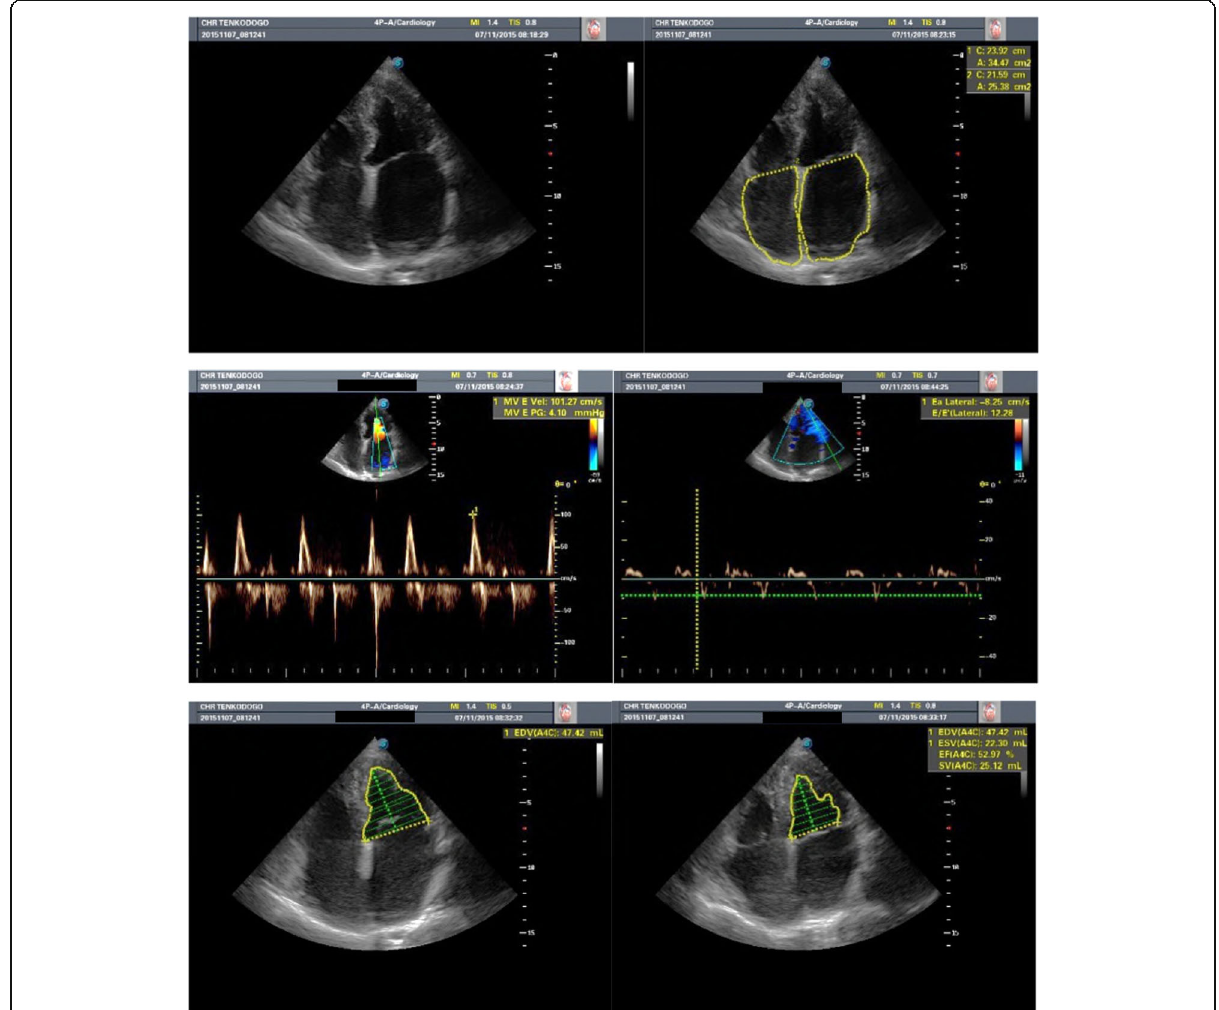
Fig. 1 Echocardiogram revealing restrictive cardiomyopathy in a 78-year-old woman with atrial fibrillation. Note the reduction of both ventricles ’ volumes, normal left ventricle (LV) wall thickness and massive bi-atrial enlargement in apical four-chamber views. The LV ejection fraction was slightly reduced with evidence of diastolic